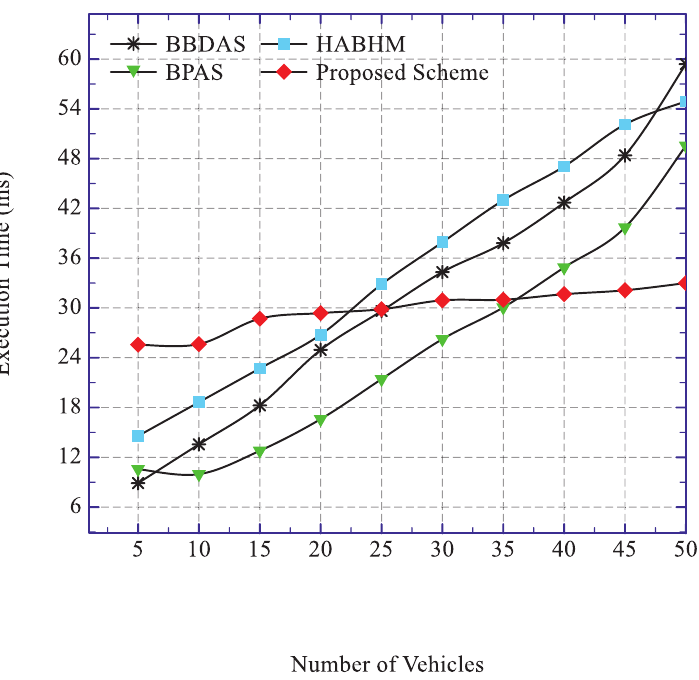
Figure 4. Comparison results on execution